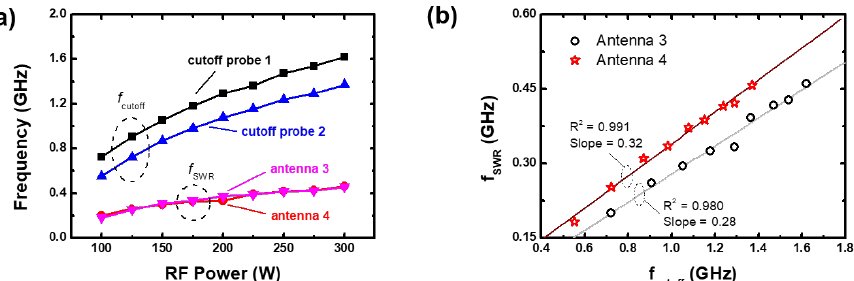
Figure 5. ( a ) Measured cutoff frequencies ( f cutoff ) and surface wave resonance frequencies ( f SWR ) with various RF power from 100 to 300 W at pressure of 100 mTorr. ( b ) The f SWR plot as a function of the f cutoff .